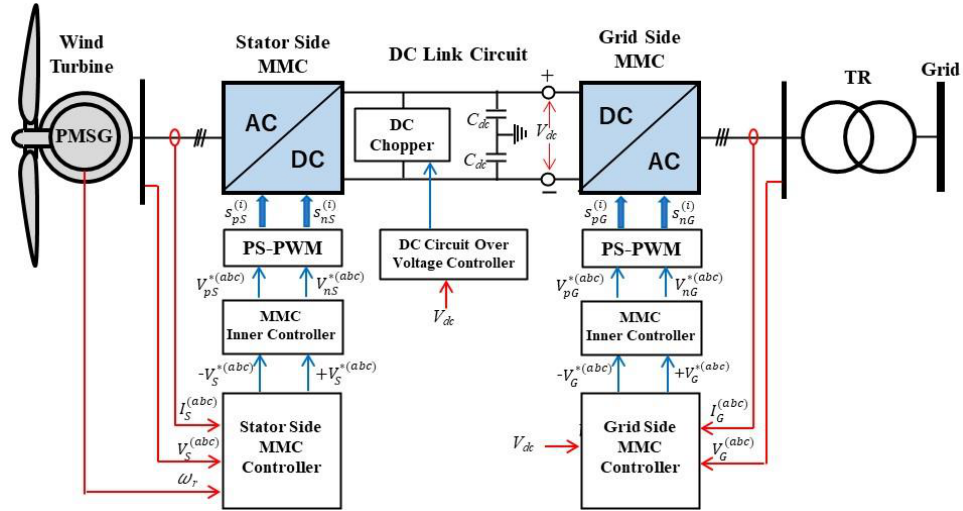
Figure 1. Configuration of the MMC-controlled wind turbine generator in the detailed model.